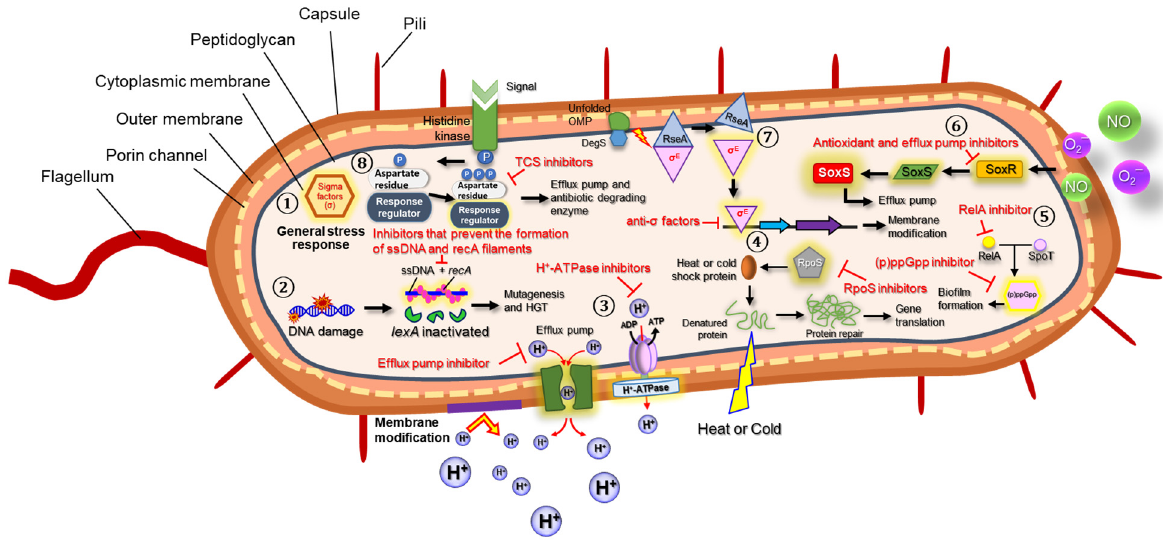
Figure 1. Overall scheme of bacterial stress responses in association with antibiotic resistance mechanisms. General stress response ( ① ), SOS response ( ② ), acid stress response ( ③ ), temperature stress response ( ④ ), starvation stress response ( ⑤ ), oxidative stress response ( ⑥ ), envelope stress response ( ⑦ ), and osmotic stress response ( ⑧ ). Single strand DNA (ssDNA), DNA repair-mediated gene ( recA ), horizontal gene transfer (HGT), adenosine diphosphate (ADP), adenosine triphosphate (ATP), stress response sigma factor (RpoS), homologue proteins (RelA and SpoT), guanosine pentaphosphate ((p)ppGpp), regulatory protein (SoxS), superoxide response regulon (SoxR), nitric oxide (NO), outer membrane protein (OMP), membrane anchored protease (DegS), anti-sigma factor (RseA), sigma factor E ( σ E ), and two-component systems (TCS).